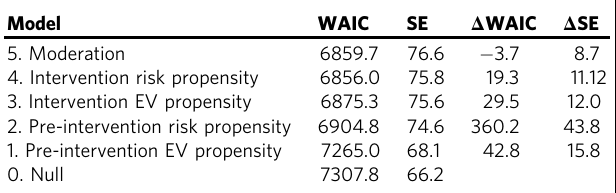
Table 3 Bayesian model